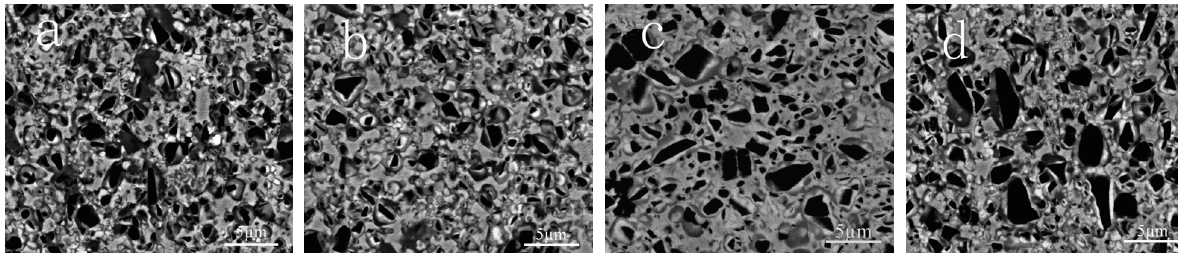
Fig. 3 Microstructures of Ti(C,N)-based cermets with the MWCNT addition of: (a) 0.2 wt%, (b) 0.5 wt%, (c) 0.8 wt%, and (d) 2.0 wt%.